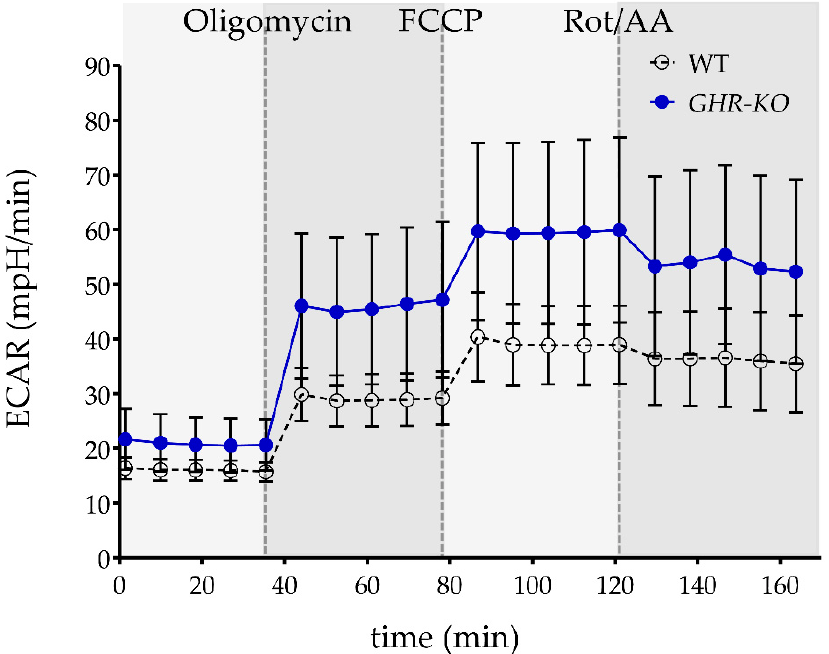
Figure 6. The extracellular acidification rate (ECAR) of PBMCs from WT pigs ( n = 7, white dots) and GHR -KO pigs ( n = 6, blue dots), indicating glycolysis after injection of oligomycin, FCCP, and Rot/AA, yielded similar ECAR, indicating similar glycolysis activity in WT and GHR -KO PBMC. Data are presented as mean ± SD.